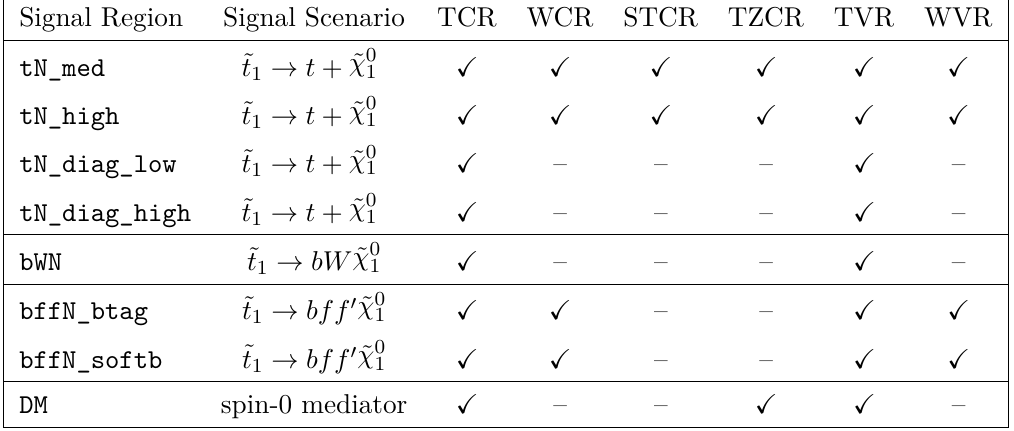
Table 9. Summary of the control and validation regions used ( X ) for each signal